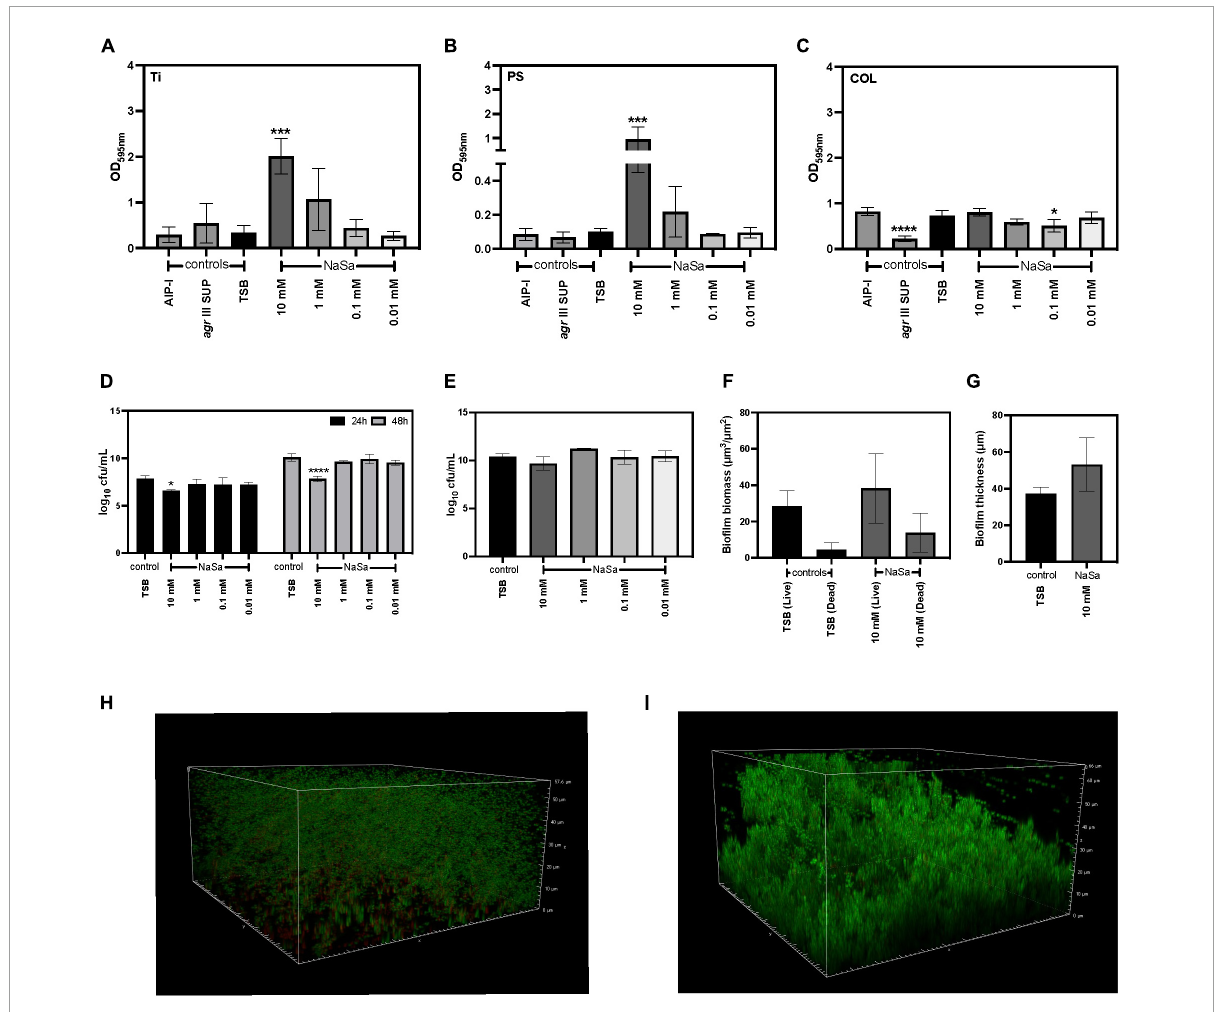
FIGURE5 NaSa influences biofilm formation of S. aureus ATCC 25923. The effect of NaSa on the production of biofilm on titanium (Ti) (A) , polystyrene (PS) (B) , and collagen-coated polystyrene (COL) (C) was assessed after 24 and 48 h. The number of dispersed (24 and 48 h) (D) and surface-attached (48 h) (E) bacteria. Effect of NaSa on S. aureus biofilm biomass (F) and thickness (G) after 24 h of growth on polystyrene. Untreated S. aureus biofilms (H) and NaSa-treated S. aureus biofilms (I) grown on polystyrene for 24 h visualized by confocal laser-scanning microscopy. Each bar represents the mean ± SD from three independent experiments. * P ≤ 0.05, *** P ≤ 0.001, **** P ≤ 0.0001, statistically significant to TSB (Tryptic Soy Broth) as media using one-way ANOVA Dunnett’s test. AIP-I, Autoinducing Peptide-I; SUP,